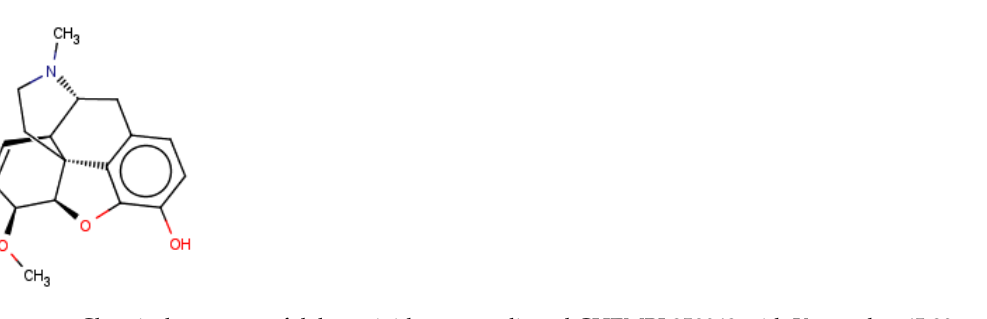
Figure 11. Chemical structure of delta-opioid receptor–ligand CHEMBL358043 with K i equal to 65.80 nM (docking score: −4.12). At first, the set of structurally similar compounds within the set of considered ligands was identified (Table 3). Table 3. The set of structurally related compounds to CHEMBL358043 present in the delta-opioid receptor dataset.